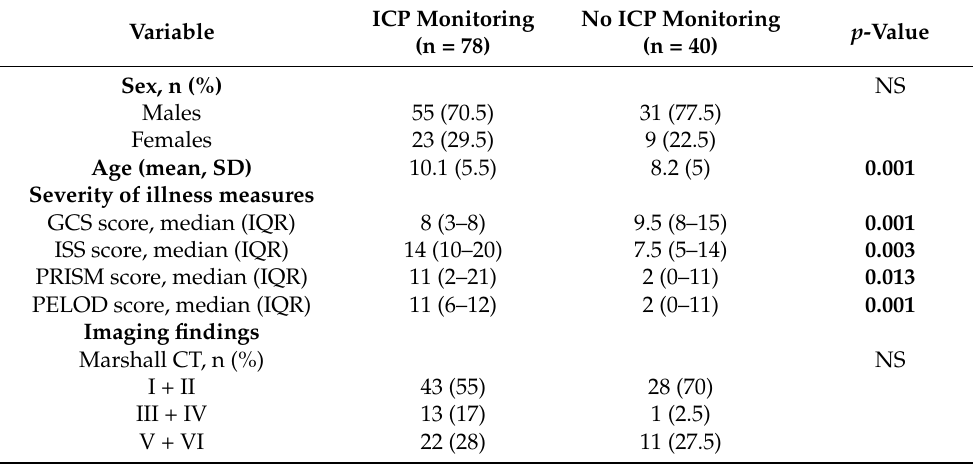
Figure 1. Frequencies of outcomes by Glasgow Outcome Scale (GOS) among different age groups. Table 1. Descriptive statistics and univariate comparisons.